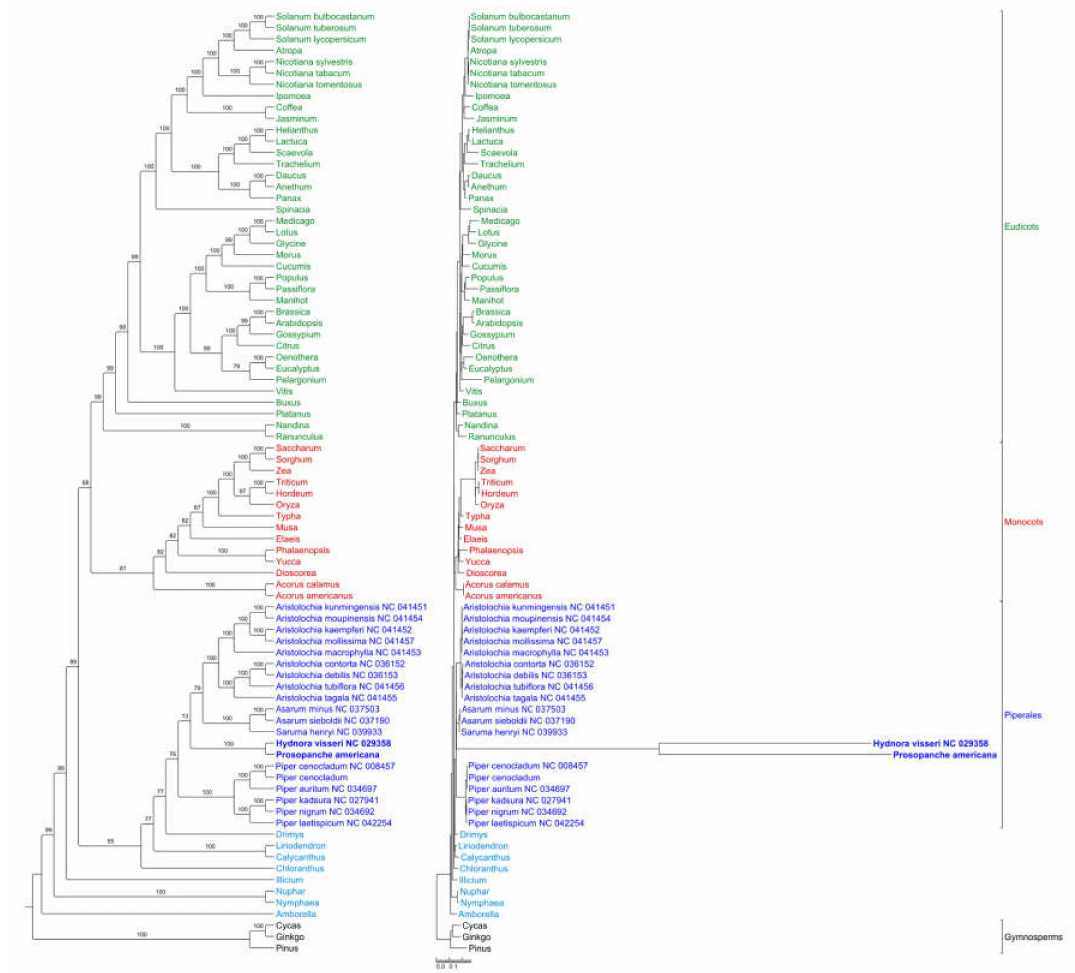
Figure 6. High mutational rate within Hydnoraceae relative to other Piperales and diverse photosynthetic angiosperms. Phylogenetic maximum likelihood tree reconstruction as cladogram (left) and phylogram (right) estimated using RAxML with the GTR + I + G model and conducting rapid bootstrapping (1000 replicates) recovers Hydnora and Prosopanche as sister genera and Hydnoraceae together as sister to a sister group of Aristolochioideae and Asaroideae (both Aristolochiaceae) within the Piperales. Bootstrap support values are displayed above the nodes. The scale bar shows the number of substitutions per site. Ingroup taxa are color coded, with eudicots being green, monocots red, Piperales dark blue and remaining Magnoliids and ANITA grade taxa light blue. Taxa refer to the dataset of Jansen et al. [42] if not otherwise indicated by GenBank